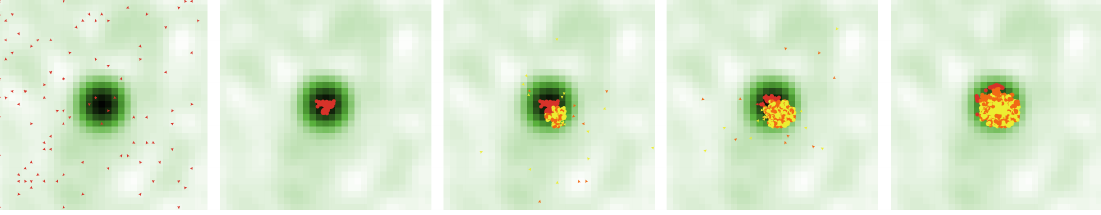
Figure 1. Evolution of Set A over time, from initialization (left) through end of simulation (right).